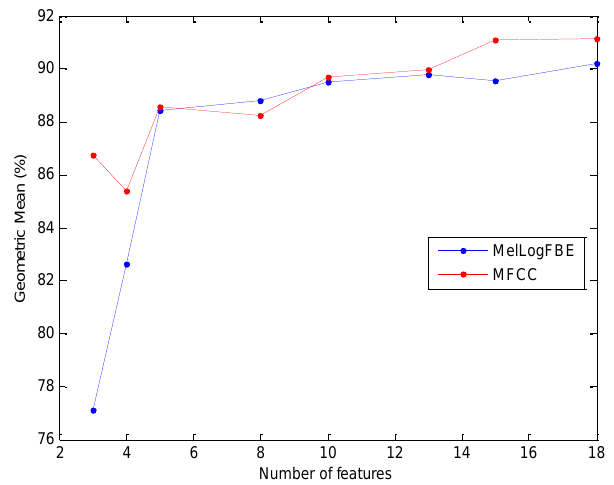
Figure 33. Geometric Mean of the best classifier vs. the number of features (optimal value in every option).